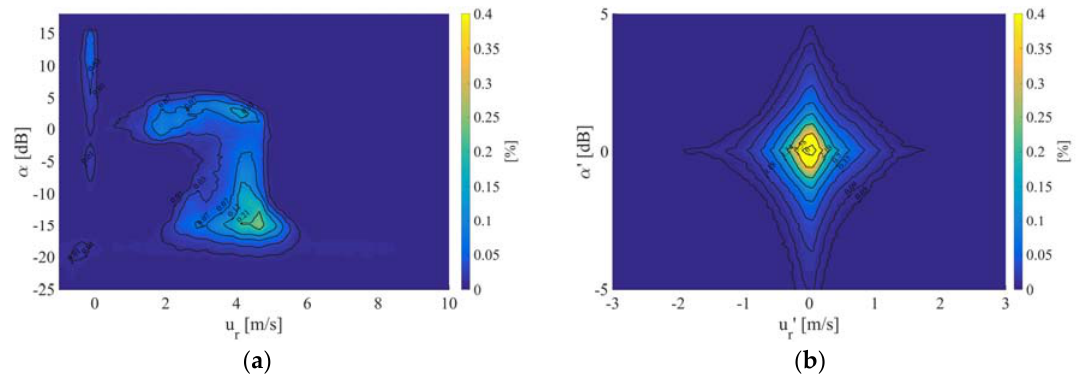
Figure 18. Visualisation of the data density distribution of Stream Line XR PPI data from 31.10.2016 00:00 h (UTC) till 31.10.2016 00:30 h (UTC) in ( a ) u r - α diagram and ( b ) in the normalised reference frame.